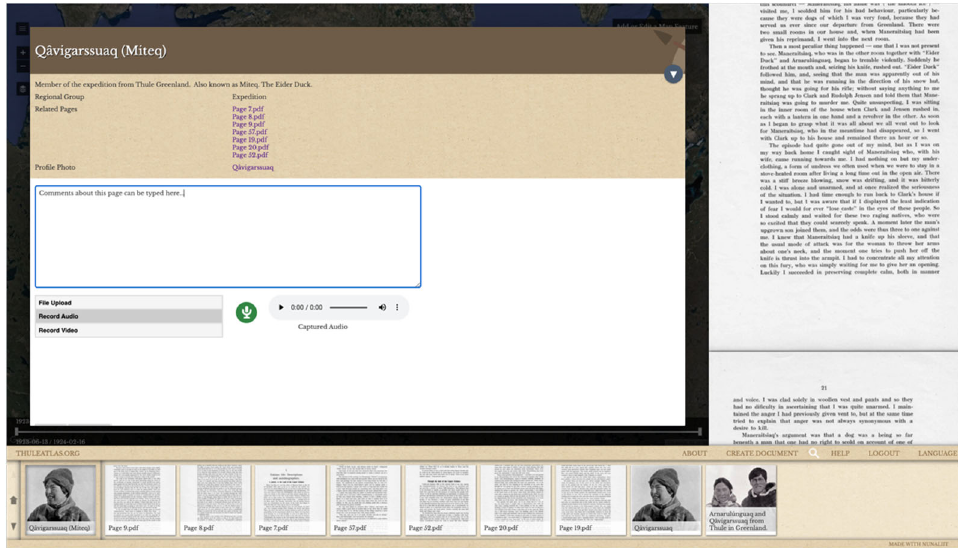
Figure 6. Functionality allows for users to link their own text, audio and video commentaries to specific expedition report pages or extracted Inuit knowledge documents.